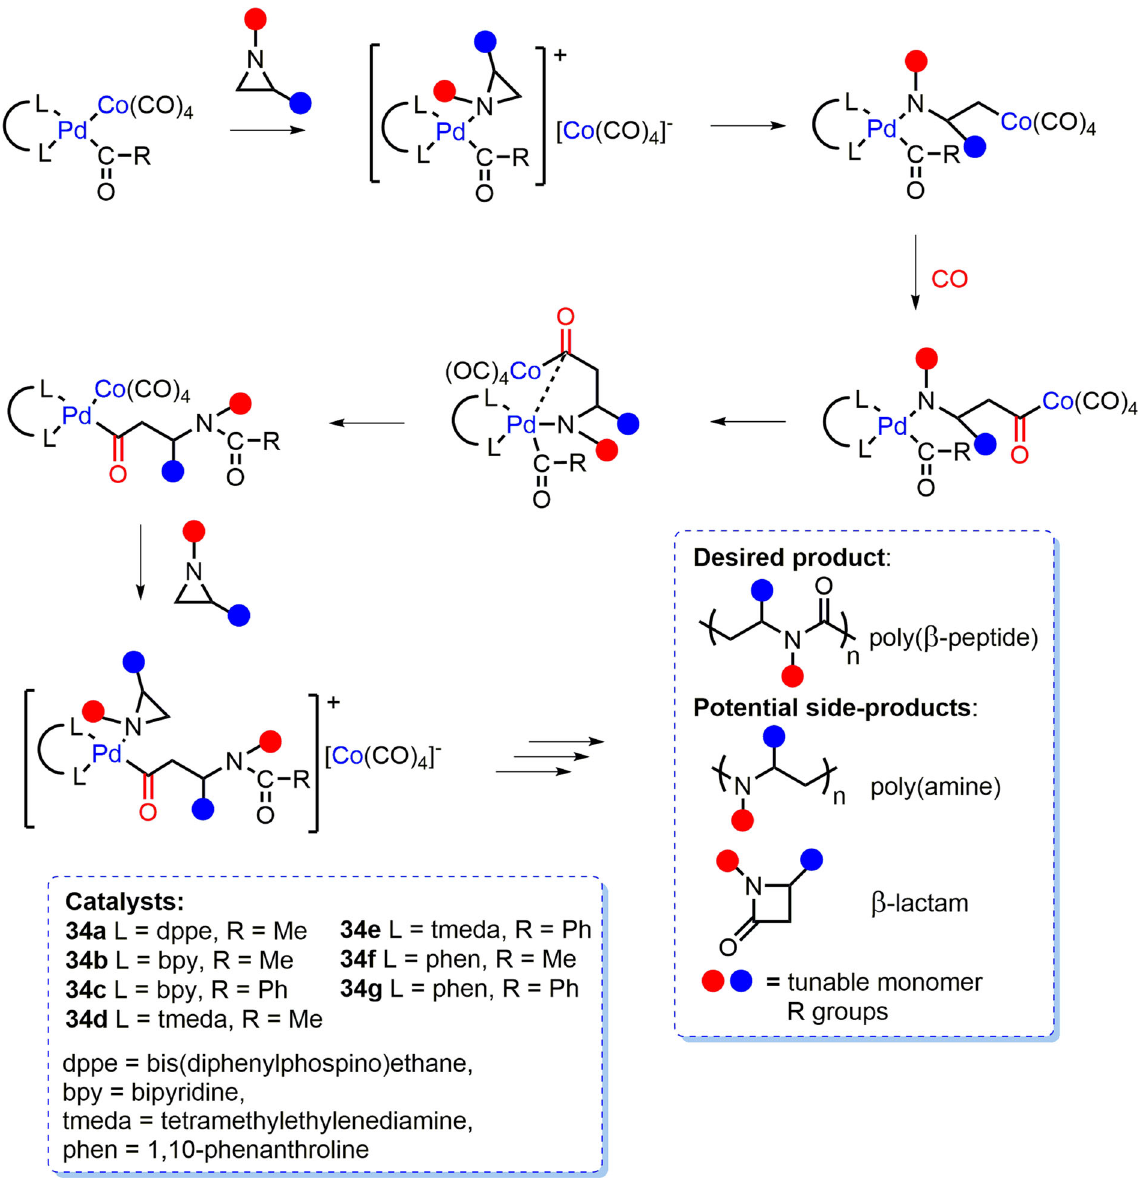
Fig. 8 Proposed aziridine/CO ROCOP mechanism for Co/Pd catalyst systems. Proposed heterometallic mechanism for complexes 34a-g along with targeted poly( β -peptide) product and potential side-products from aziridine/CO ROCOP 109